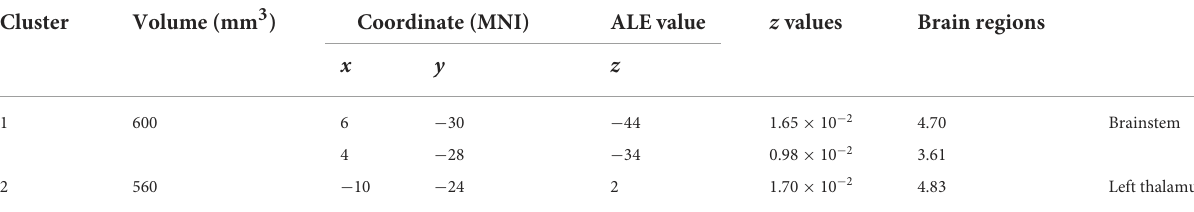
TABLE 4 The ReHo values changings of migraine patients by ALE